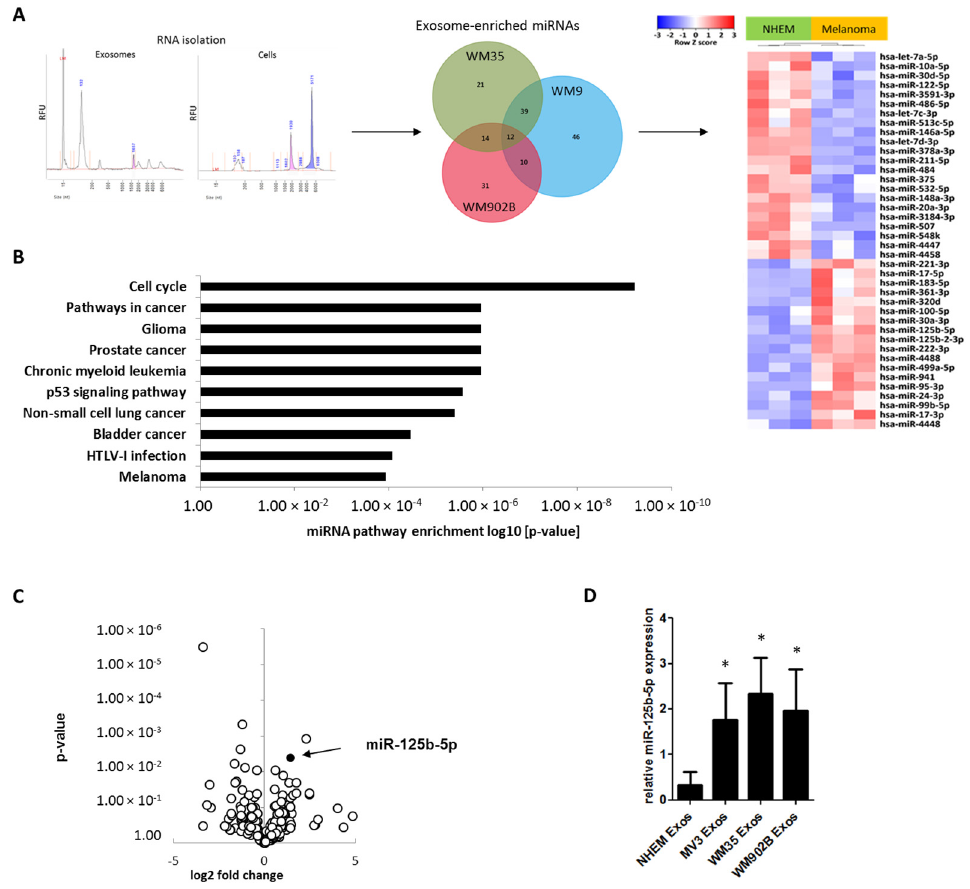
Figure 3. miR-125b-5p is enriched in melanoma exosomes. Next-generation sequencing (NGS) analysis of exosome small RNA load. ( A ) Quality control of isolated RNA from exosomes and whole cells. Heatmap shows the differential miRNA expression of normal human epidermal melanocytes (NHEMs) and melanoma cell lines (WM9, WM35, and WM902B). Venn diagram shows differential enrichment of miRNAs in exosomes of different cell lines compared to NHEMs. ( B ) miRNet miRNA pathway enrichment of the top five abundant and most significantly enriched miRNAs in the melanoma-derived exosomes (hsa-miR-100-5p, hsa-miR-99b-5p, hsa-miR-221-3p, hsa-miR-24-3p, and hsa-miR-125b-5p). ( C ) Volcano plot shows miRNA enrichment of miR-125b-5p in exosomes derived from the melanoma cell lines compared (WM9, WM35, and WM902B) to NHEM-derived exosomes. ( D ) Validation of miR-125b-5p enrichment in melanoma cell line-derived exosomes by qRT-PCR. Bars represent the average ± standard deviation of at least three independent experiments (* p ≤ 0.05).